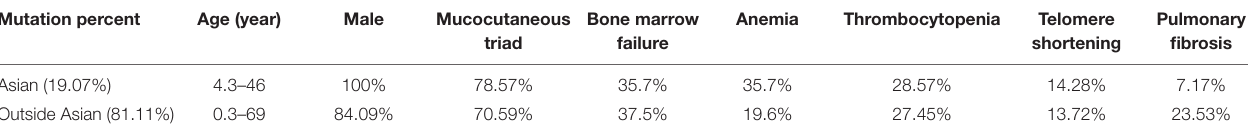
TABLE 3 | The Asian and outside Asian variations and the main clinical